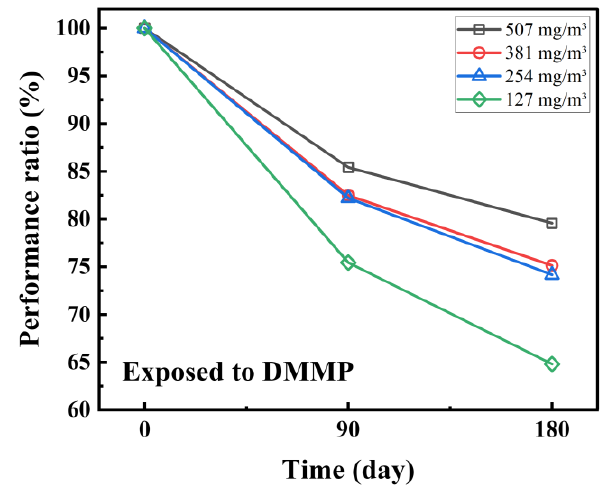
Figure 10. Performance over time of the SAW sensor coated with POSS.